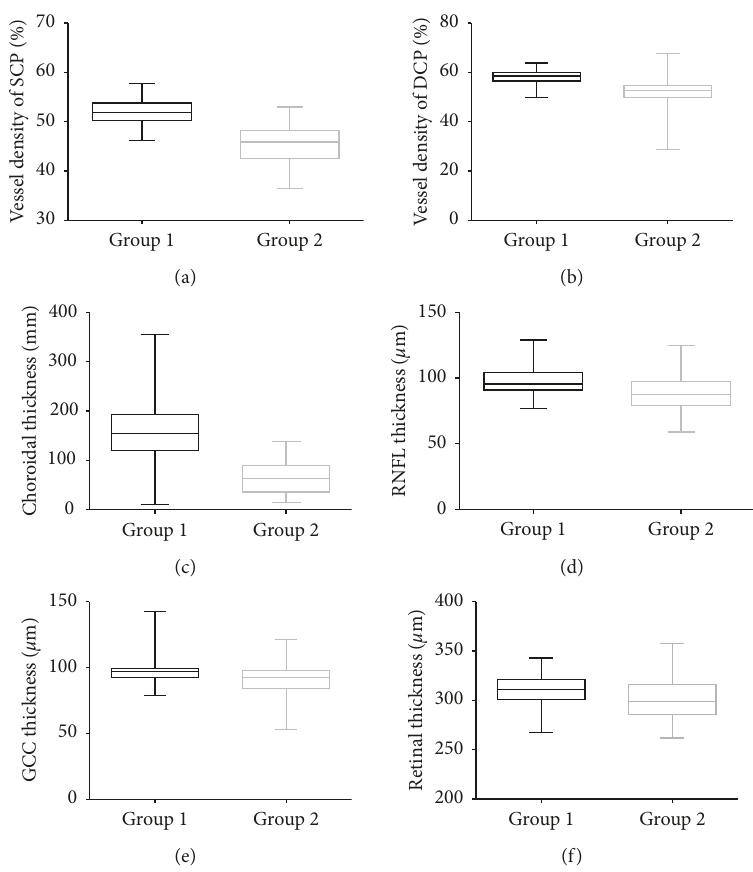
Figure 2: Comparison of the vessel density in the superficial retinal capillary plexus (SCP) (a), vessel density in the deep retinal capillary plexus (DCP) (b), choroidal thickness (c), retinal nerve fiber layer (RNFL) thickness (d), ganglion cell complex (GCC) thickness (e), and retinal thickness (f) in groups 1 and 2. All differences between groups 1 and 2 are significant ( P < 0 . 05). Table 3: Logistic regression analysis of factors associated with diffuse chorioretinal atrophy.